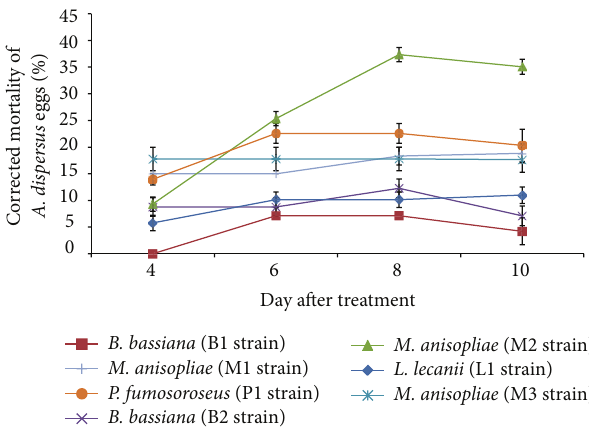
Figure 2: Pathogenicity of entomopathogenic fungi against A. dis- persus nymphs. Figure 3: Ovicidal action of entomopathogenic fungi against A. dispersus eggs.